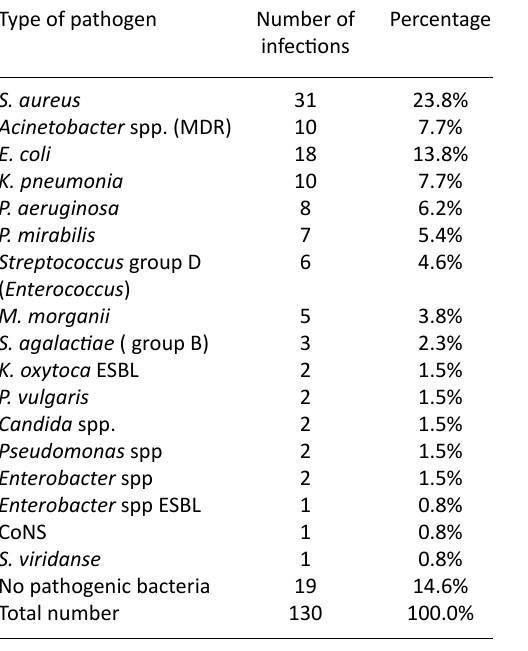
Table 4-B.1. Diabetic foot ulcer infections